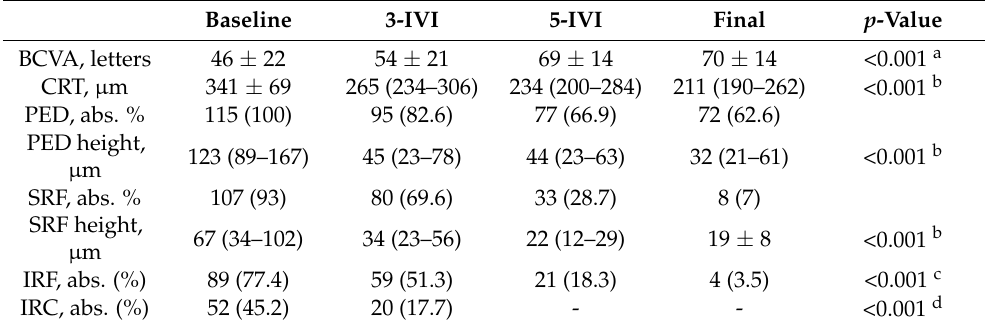
Table 5. Characterization of functional and anatomical parameters of the retina in patients with nAMD at baseline and during anti-VEGF therapy.